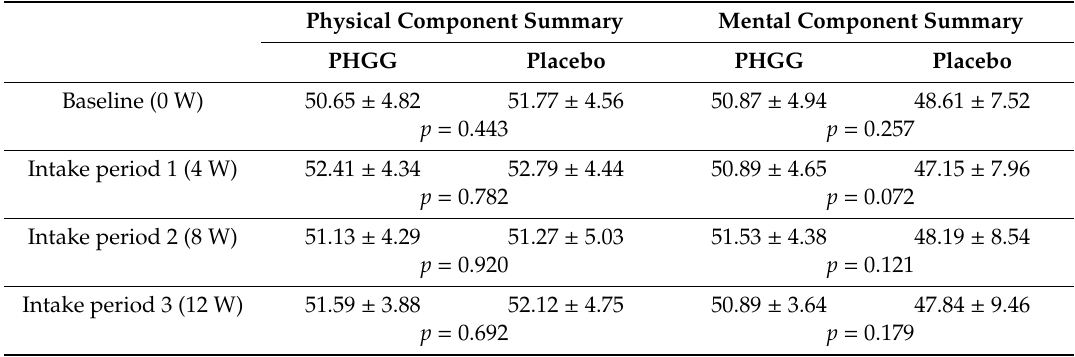
Table 2. Physical and mental component summaries of quality of life, elucidated using the SF-8 questionnaire.